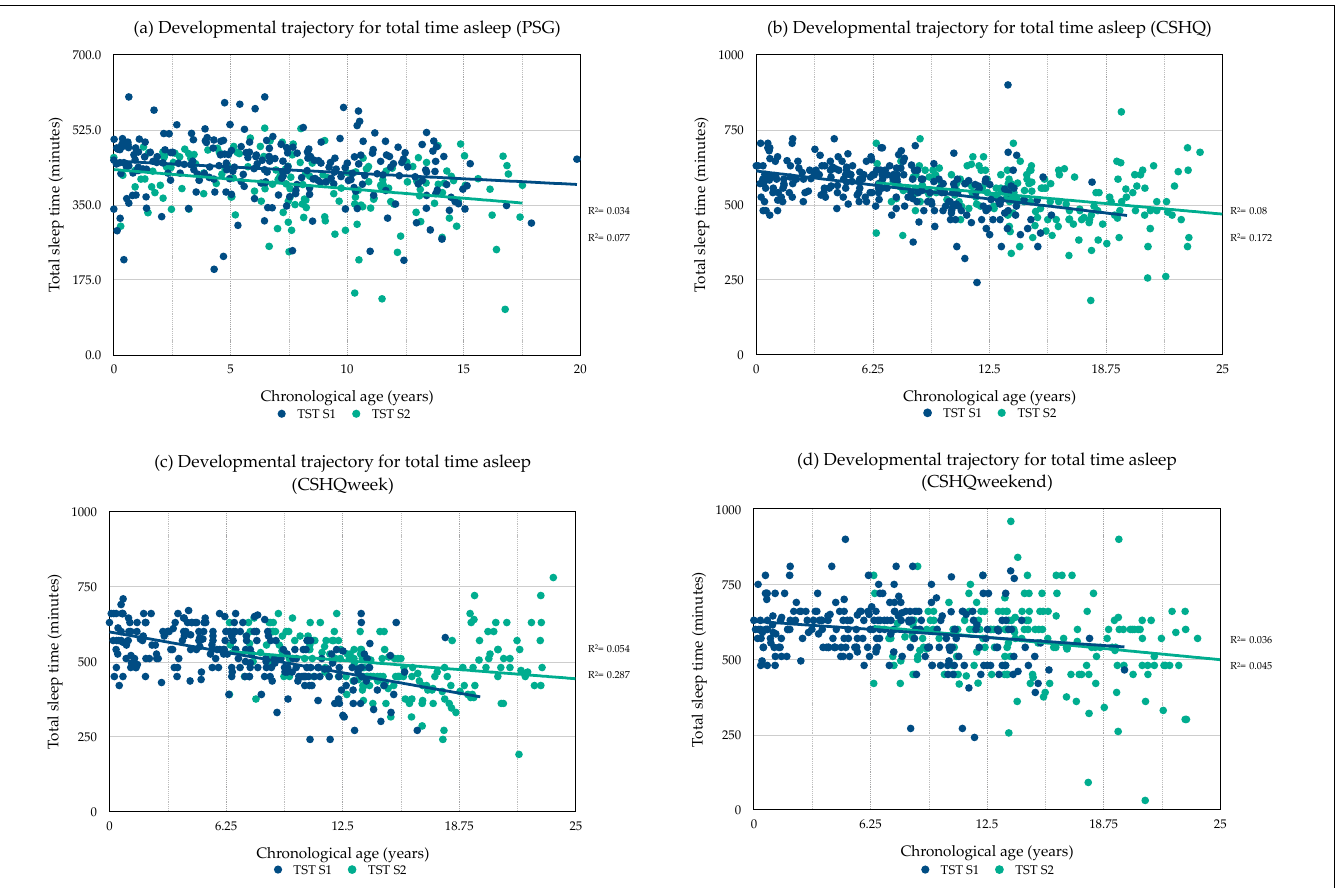
Figure 2. Developmental trajectory for sleep behavirur in sickle cell anaemia. Note: CSHQ = Children’s Sleep Habit Questionnaire, PSG = Polysomnography.